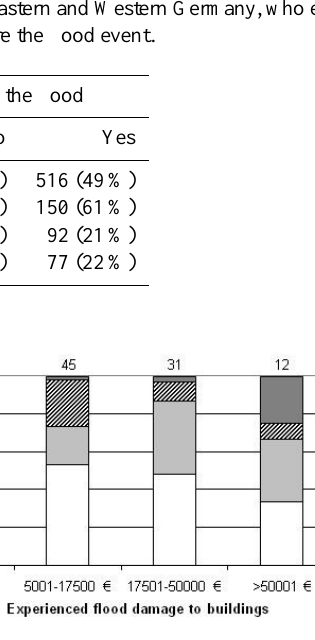
Fig. 4. Experienced flood damage to buildings in Germany and the Figure 4. Experienced flood damage to buildings in Germany and the frequency of answers of frequency of answers of willingness to pay (WTP) for flood insur- willingness-to-pay (WTP) for flood insurance by private households ance by private